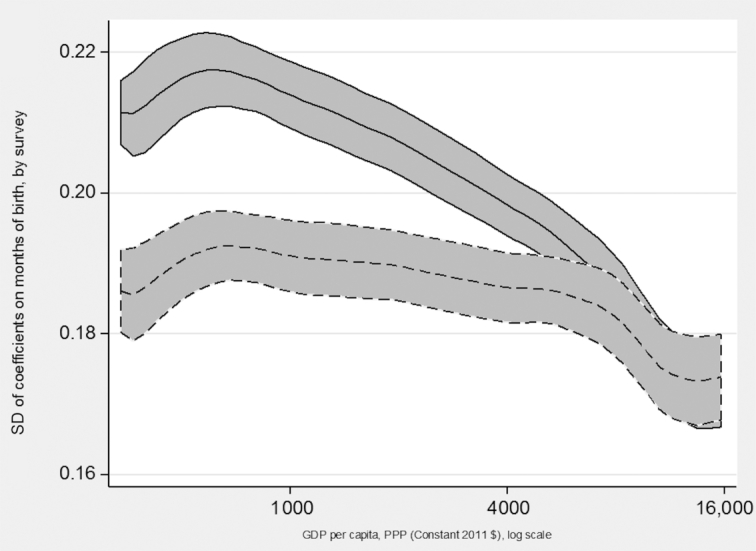
GDP and seasonality in HAZ across 218 DHS surveys: SD of estimated coefficients. Lines are local polynomial smoothing regressions of degree zero with 95% CIs and an Epanechnikov kernel. Solid line is estimates before the linear correction for misreported MOB. Dotted line is after the linear correction for misreported MOB. DHS, Demographic and Health Surveys; GDP, Gross Domestic Product; HAZ, height-for-age z-score; MOB, month of birth; PPP, Purchasing Power Parity.